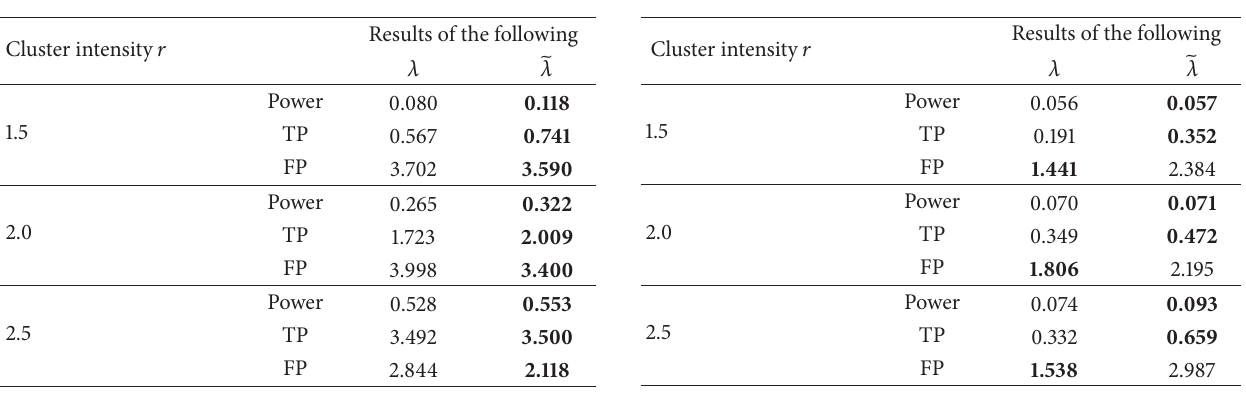
Table 1: Homogeneous Gaussian model. Table 2: Exponential model.